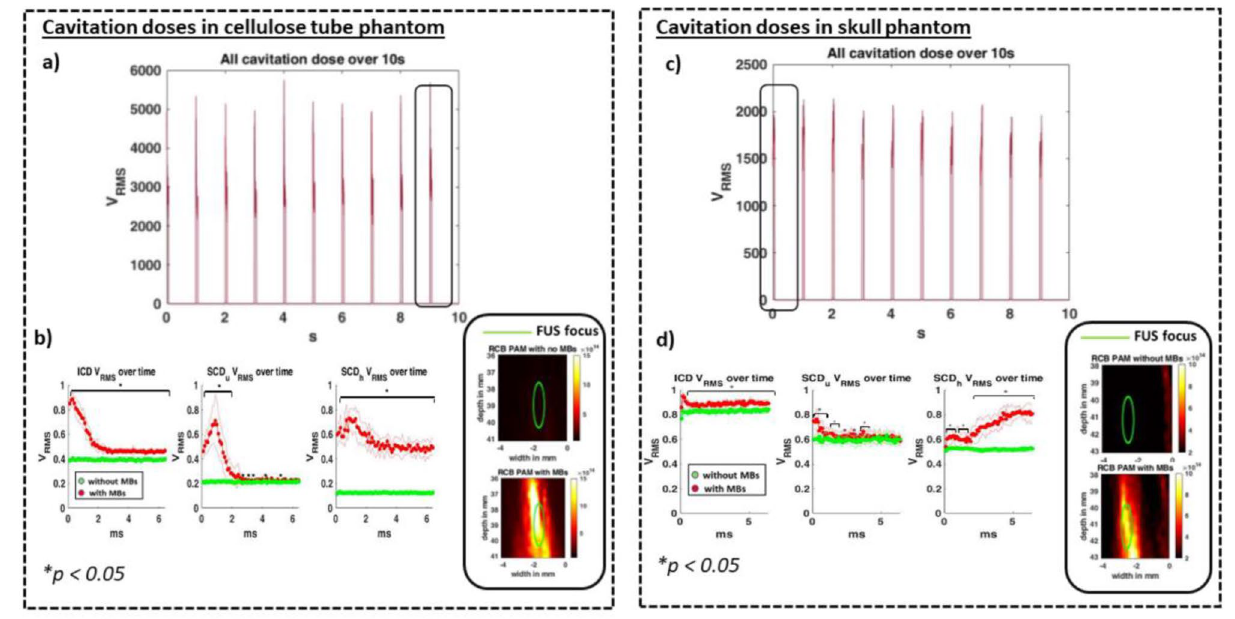
Figure 3. Cavitation dose analysis in in vitro phantoms. ( a ) Total cavitation doses (ie. the sum of ICD, SCDh, and SCDu) versus time in cellulose tube phantom. ( b ) During a single pulse, the mean ICD, SCDh and SCDu of each burst show that FUS sonication of MBs yielded greater doses than FUS sonications of saline and the doses were found to be statistically significantly greater. In ICD and SCDh, the values were statistically significant throughout the on pulse. The MBs peaks of ICD, SCDu and SCDh was 7.4 dB, 10.9 dB and 15 dB greater than saline respectively. A mean passive acoustic map of 69 pulses of the last 1 s sonication shows cavitation activity in the desired region in green circle. ( c ) Total cavitation doses (ie. the sum of ICD, SCDh, and SCDu) versus time in cellulose phantom through skull. ( d ) ICD, SCDu, and SCDh values during MBs sonications were found to be statistically significantly greater than saline sonications. The MB peaks of ICD, SCDu and SCDh was 1.6 dB, 2.5 dB and 4 dB greater than saline respectively. A mean passive acoustic map of 69 pulses of the fisr 1 s sonication shows cavitation activity in the desired